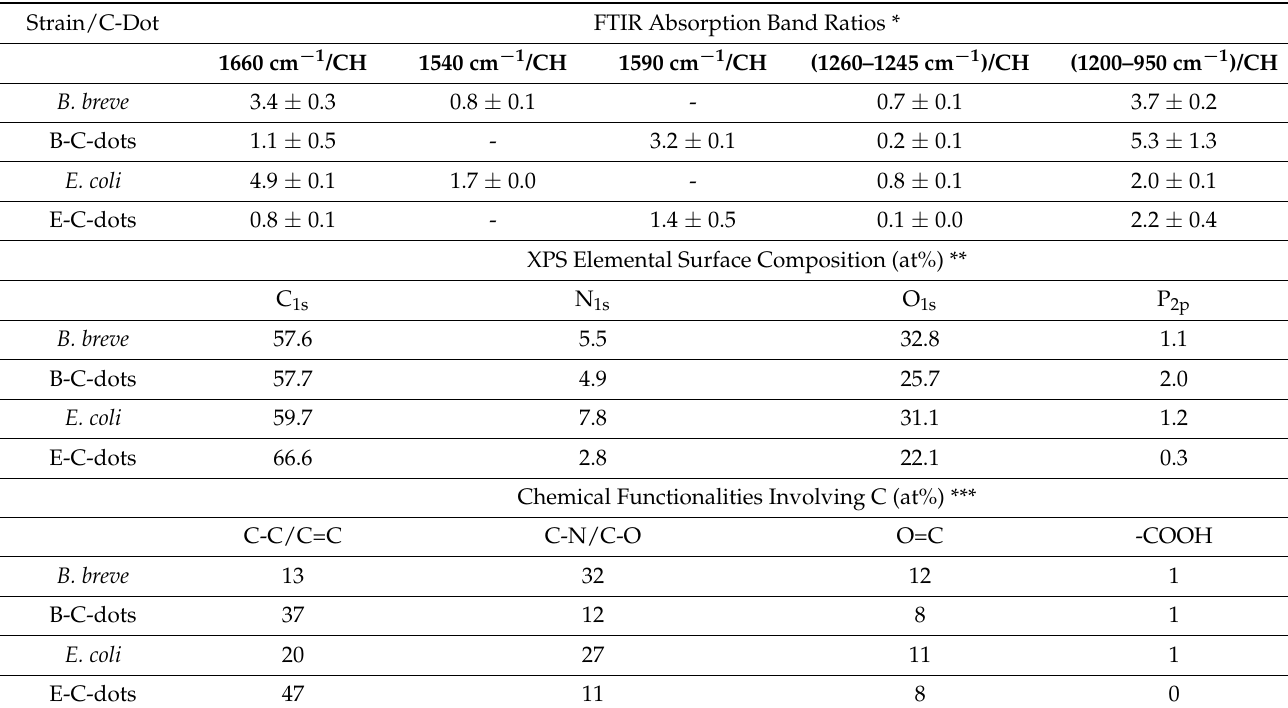
Table 1. FTIR absorption band ratios with respect to the C-H absorption band between 2950 and 2850 cm − 1 and elemental surface compositions derived from XPS spectra for B. breve ATCC 15700 and B-C-dots, E. coli ATCC 25922 and E-C-dots. FTIR absorption band ratios are averages ± standard deviations over triplicate experiments with separately prepared nanoparticles and different bacterial cultures, while XPS was done in